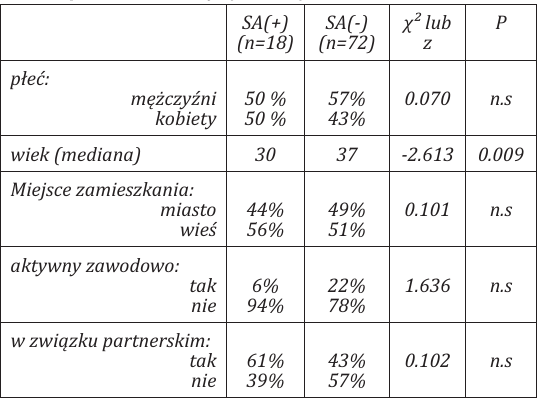
Tab.1. Porównanie zmiennych społeczno - demograficznych u osób z próbami samobójczymi w wywiadzie i